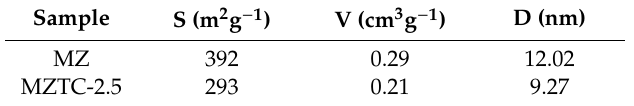
Table 1. Specific surface area (S), pore volume (V) and average pore diameter (D) for MZ and MZTC- 140